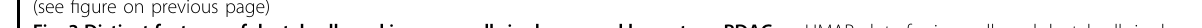
Fig. 3 Distinct features of ductal cells and immune cells in dense- and loose-type PDACs. a UMAP plot of acinar cells and ductal cells in dense- and loose-type PDACs. b Proportion of cells from acinar and ductal cells in dense- and loose-type PDACs. c Violin plots of selected marker genes from clusters 0, 2, and 6, showing normalized expression in the different clusters. d KEGG and GO analysis comparing cluster 6 against cluster 2. e Reclustering of T-cell types in the data set (clusters 4, 5, and 19 from Fig. 1c), represented as a UMAP plot. f Proportion of T-cell subpopulations in dense- and loose-type PDACs (four dense cases, three loose cases). The proportion of the CD8 + T-cell group in all T cells is signi fi cantly increased in loose-type PDAC. The y axis represents the proportion of each T-cell subgroup in all T cells, and the x axis represents different T-cell subgroups. Red column and green column represent dense-type PDAC and loose-type PDAC, respectively. Data are presented as means ± SEM. All statistical analyses were performed with the two-sided Mann – Whitney U test. * P < 0.05. g GSEA showing enriched pathways in CD8 + T cells comparing loose-type against dense-type PDAC. h Multiplex immuno fl uorescence staining was conducted in nine PDAC samples undergoing scRNA-seq to con fi rm the correlation between CAF subpopulations and in fi ltrating CD8 + T cells ( n = 9, POSTN for myCAF, PLA2G2A for meCAF, CD8 for CD8 + T cell). Representative immuno fl uorescence results showed much more in fi ltrating CD8 + T cells in loose-type PDAC than in dense-type PDAC. i Quanti fi cation of CD8 + T cells for n = 7 cases (four dense cases and three loose cases), including representative case. The y axis represents percentage of CD8 + T cell per visual fi eld (40×), and the x axis indicates dense-type PDAC and loose-type PDAC, respectively. Data are presented as means ± SEM. All statistical analyses were performed with the two-sided Mann – Whitney U test. * P < 0.05. j GSEA showing enriched pathways in macrophages comparing loose-type against dense-type